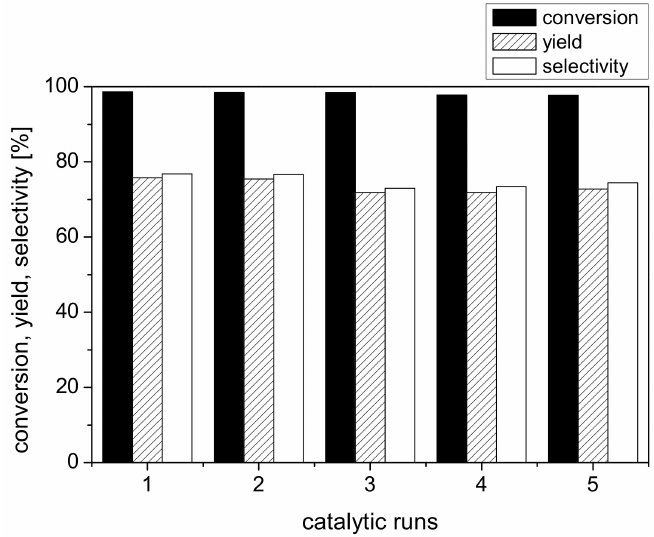
Figure 6. Recyclability of Lewatit K2420 (25–100 µ m). Reaction conditions: 0.5 M fructose, 15 vol % water in HFIP, 22 g/L (23.8 mol %) Lewatit K2420 (25–100 µ m), 105 ◦ C and 135